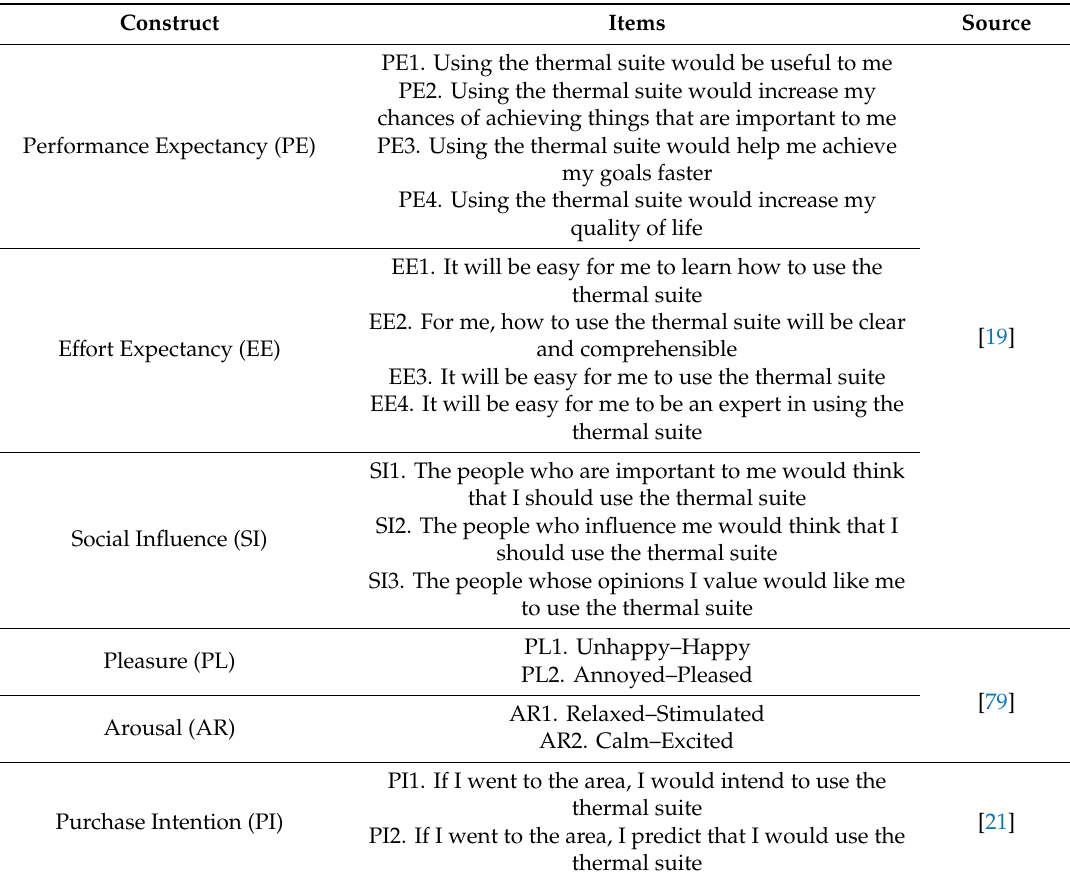
Table 2. Scale items used to measure the model’s